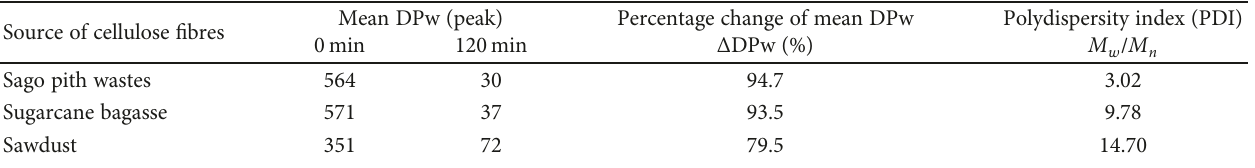
Table 1: Mean DPw peak values and polydispersity indices (PDI) for cello-oligomers derived from various types of lignocellulosic biomass wastes.